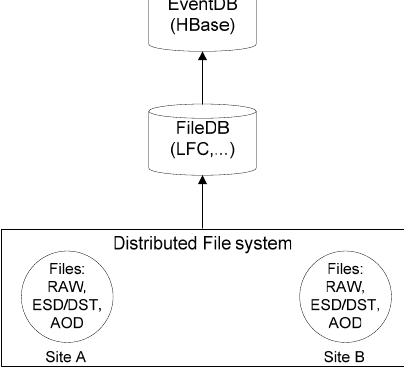
Table 1. Event Index examples in HBase. Fig. 3. The workflow of creation of indexes .